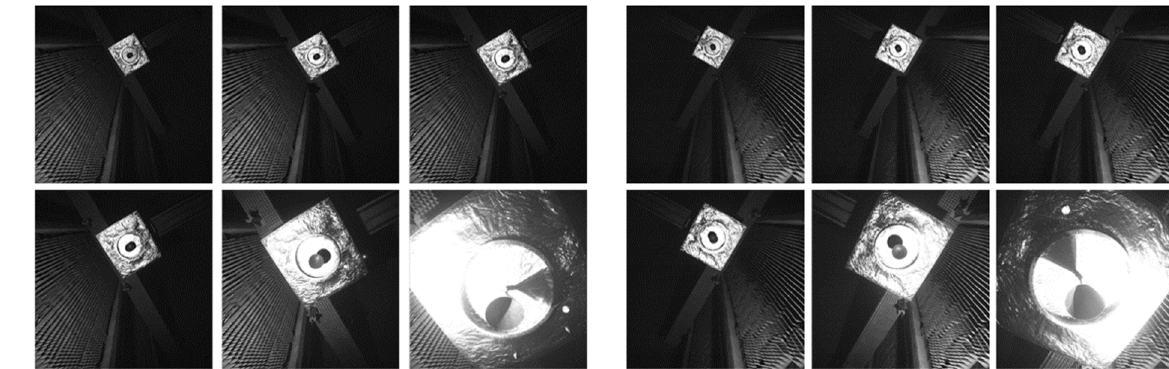
Figure 10. Non ‐ cooperative target motion acquisition images. Figure 10. Non-cooperative target motion acquisition images.